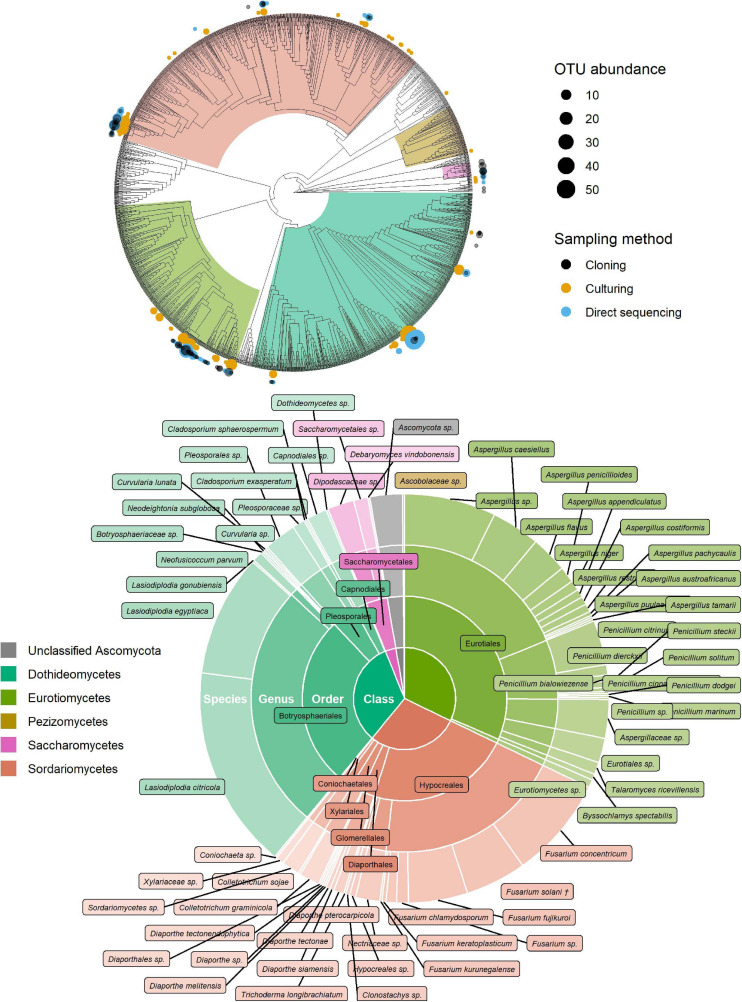
Identification of ascomycete OTUs according to UNITE and phylogenetic placement in the T-BAS Pezizomycotina v2.1 tree. OTUs from this study are indicated on the T-BAS tree by circles on tips (top) with size proportional to number of times the OTU was detected and colour showing sampling method. Taxon classification as agreed by UNITE and T-BAS is summarised in a pie chart (bottom). (†) Fusarium solani = Neocosmospora solani (Sandoval-Denis et al., 2019).